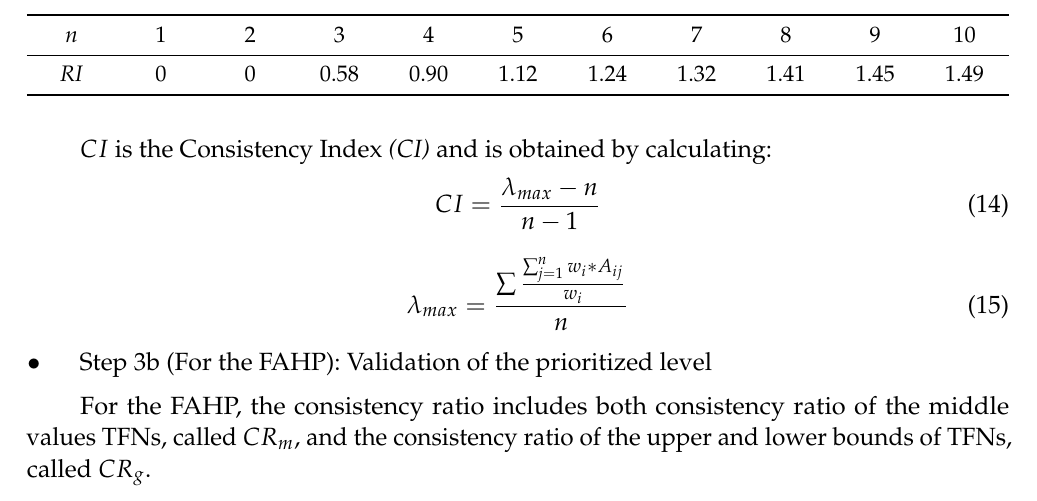
Table 2 below. Table 2. Random Index based on the number of Table 2. Random Index based on the number of criteria.